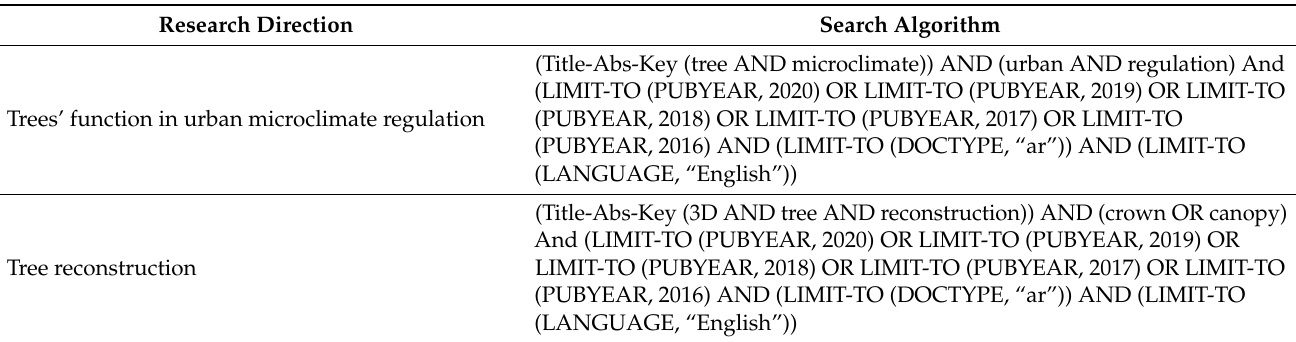
Table 1. Research algorithms for two research